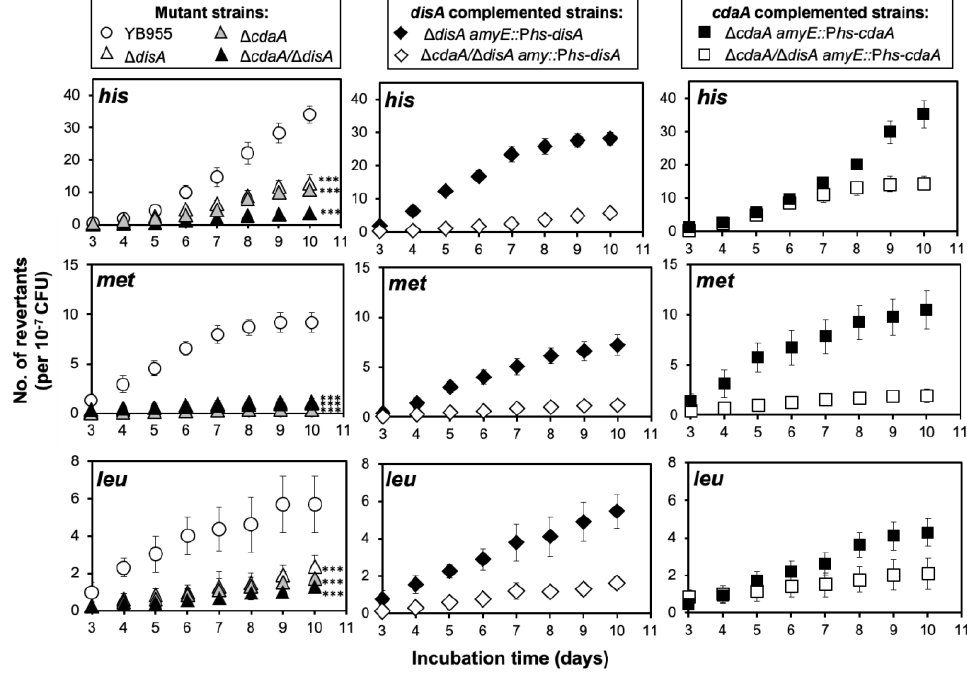
Figure 5. Frequencies of stress-associated reversions for his, met , and leu mutant genes of B. subtilis strains YB955 (open circles), Δ cdaA (dark grey triangles), Δ disA (open triangles) Δ cdaA /Δ disA (black triangles ) Δ disA amyE::Phs-disA (filled diamonds), Δ cdaA /Δ disA amyE:: P hs-disA (open diamonds), Δ cdaA amyE:: P hs-cdaA (filled squares) and Δ cdaA /Δ disA amyE:: P hs-cdaA (open squares) as described in Materials and Methods. Data represent counts from six plates averaged from three independent experiments normalized to initial cell titters ± standard deviations. All strains were supplemented with IPTG 0.25 mM. *** represent significant statistical differences compared to the parental strain, as determined by a one-way ANOVA and Tukey HSD test (all p -values < 0.001).